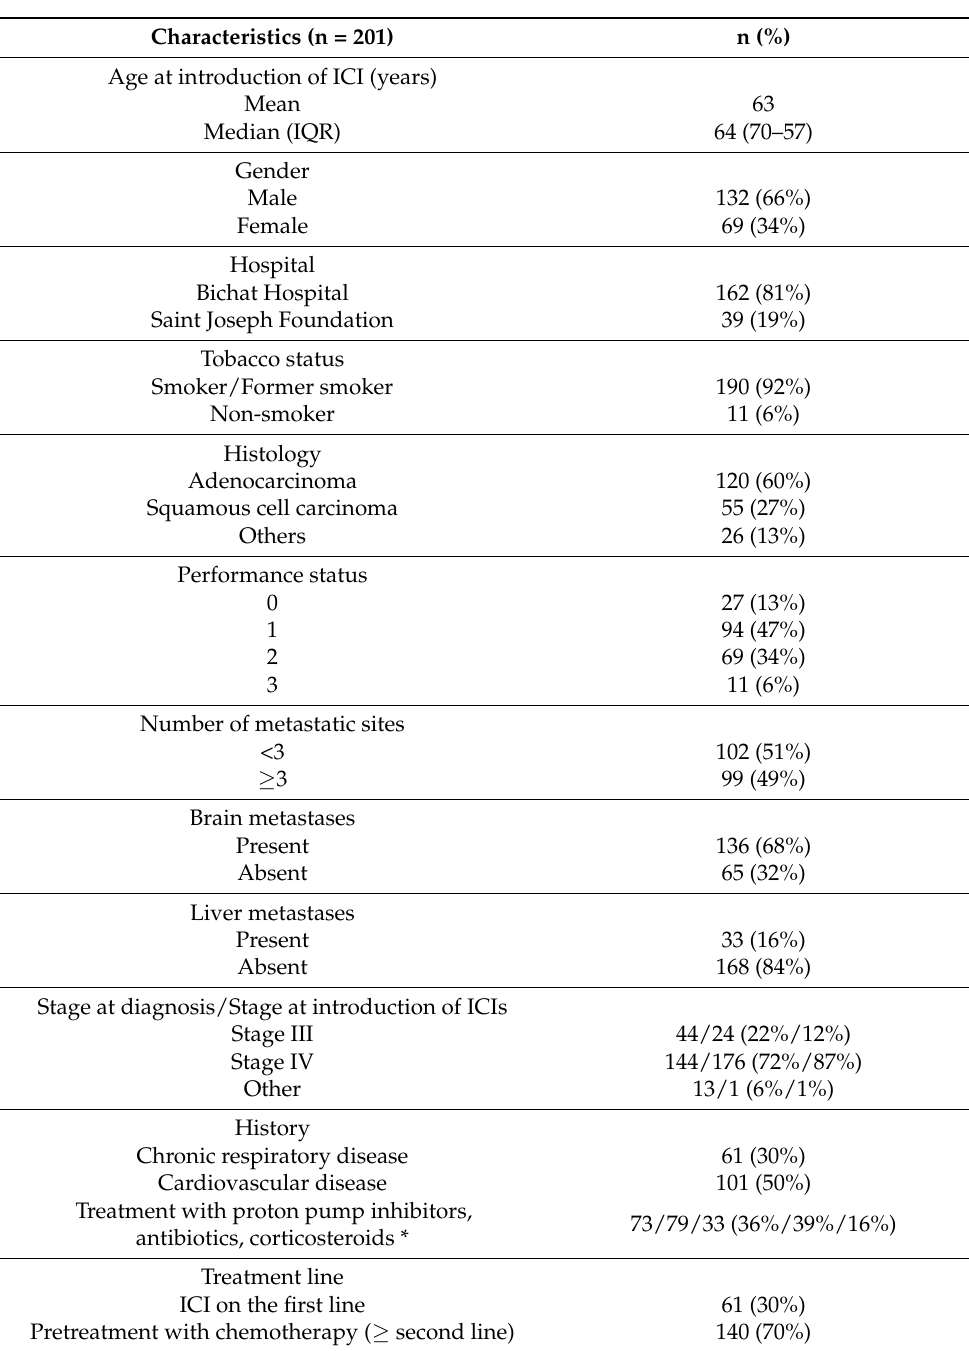
Table 1. Baseline